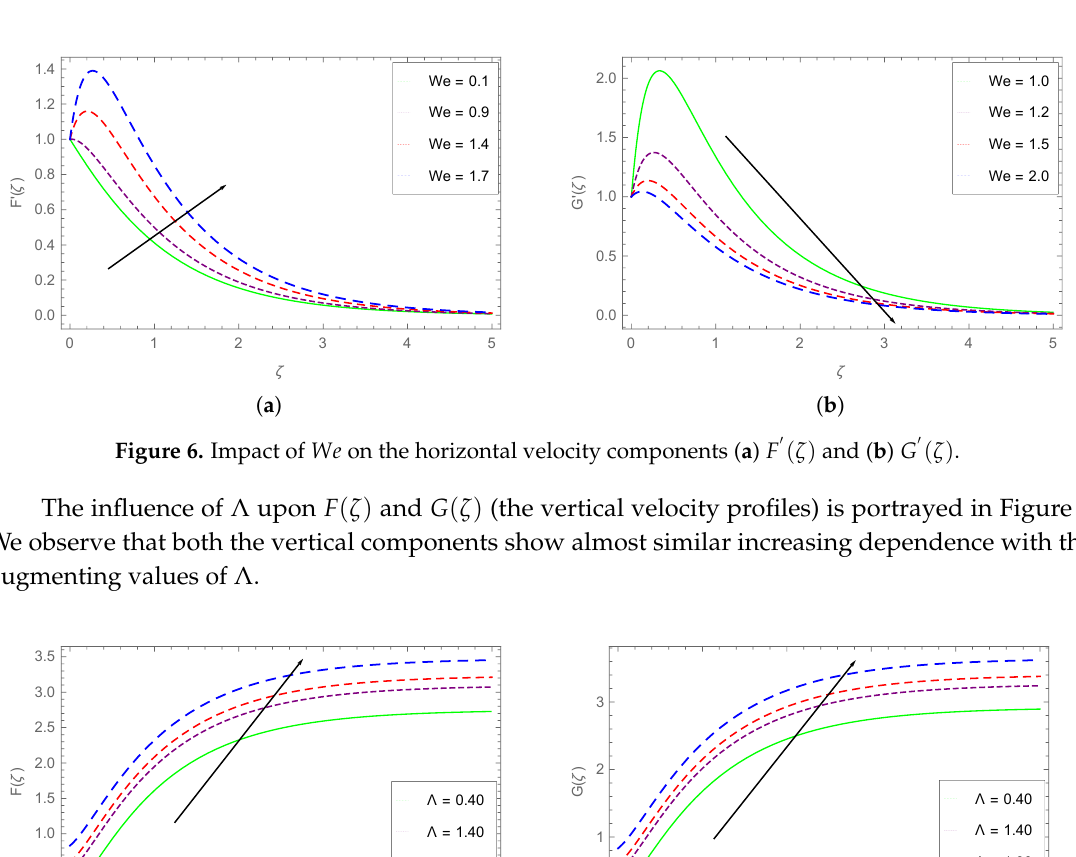
Figure 5. Impact of c on the shear stresses ( a ) F (cid:48)(cid:48) ( ζ ) and ( b ) G (cid:48)(cid:48) ( ζ ) .